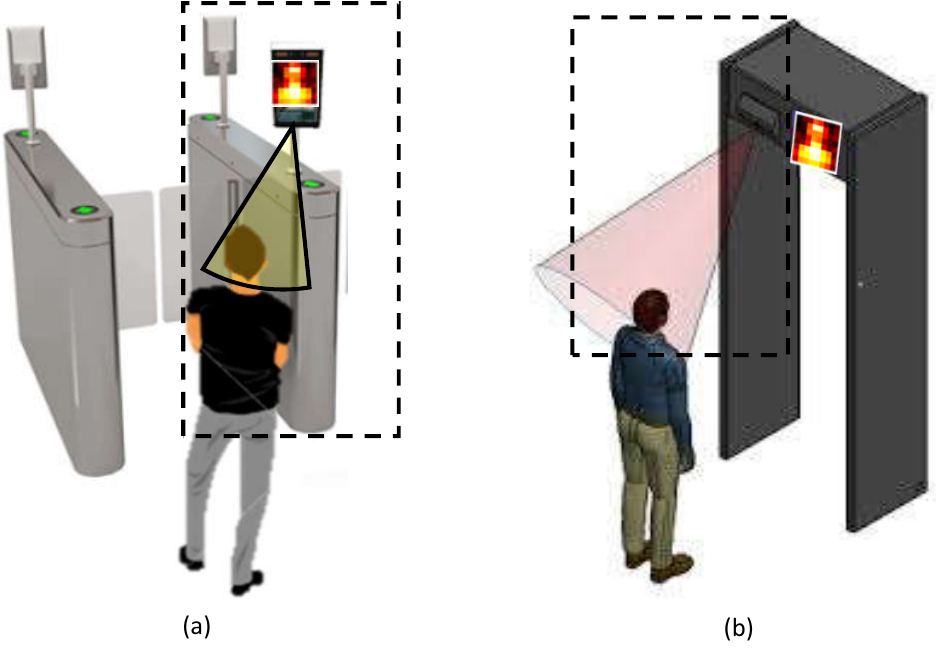
Figure 1. Illustration of the proposed thermopile-based respiratory gating solution that contactlessly screen the RR of a subject at the entrance gate. ( a ) Entry gate, ( b ) security